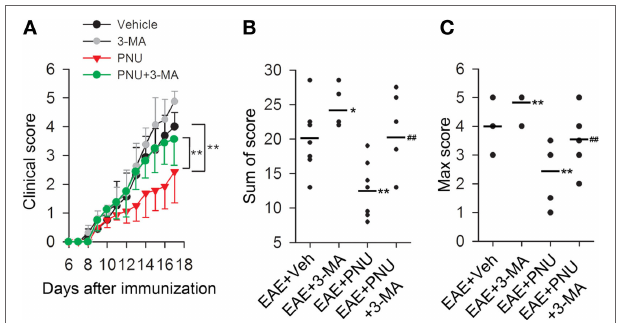
FigUre 3 | Blockade of autophagy with 3-methyladenine (3-Ma) attenuates the alleviative effects of α 7nachr activation on severity in experimental autoimmune encephalomyelitis (eae) mice . EAE mouse models were created. PNU282987 (0.1 mg/kg, i.p.) was given for the activation of α 7nAChR and 3-MA (10 mg/kg, i.p.) was given for the blockade of autophagy process in vivo . The clinical score (a) , sum of score (B) , and max score (c) were assessed for the analysis of the extent of EAE severity ( n = 8 per group). * P < 0.05 vs Veh, ** P < 0.01 vs Veh, ## P < 0.01 vs PNU. Veh, vehicle; PNU,